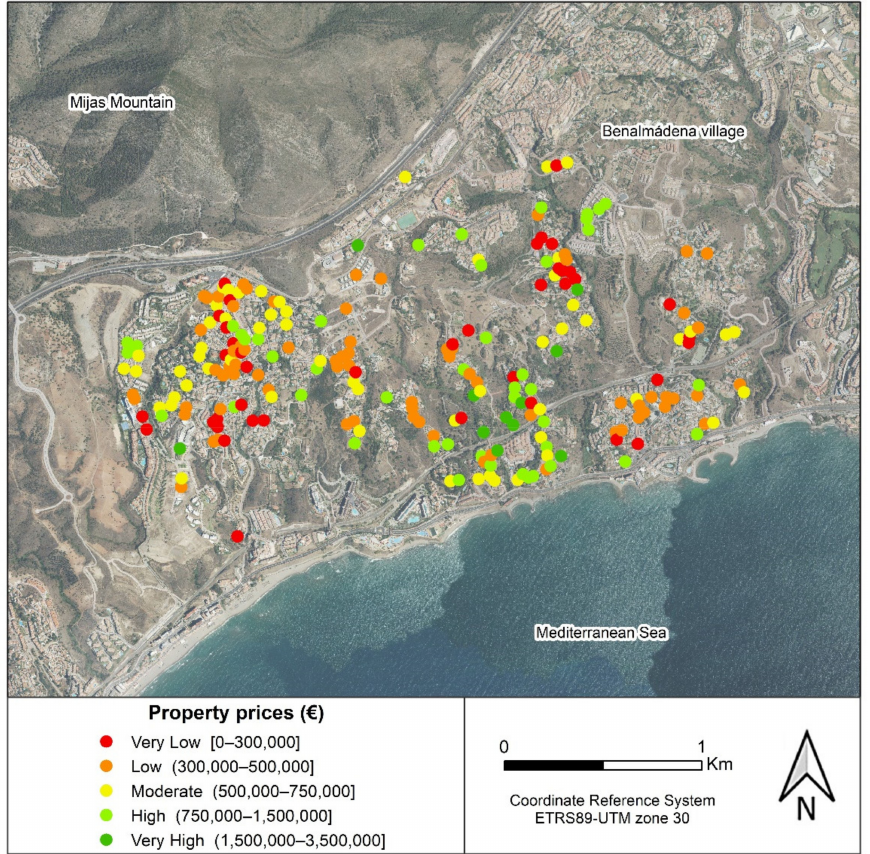
Figure 12. Estimation of real estate prices (own